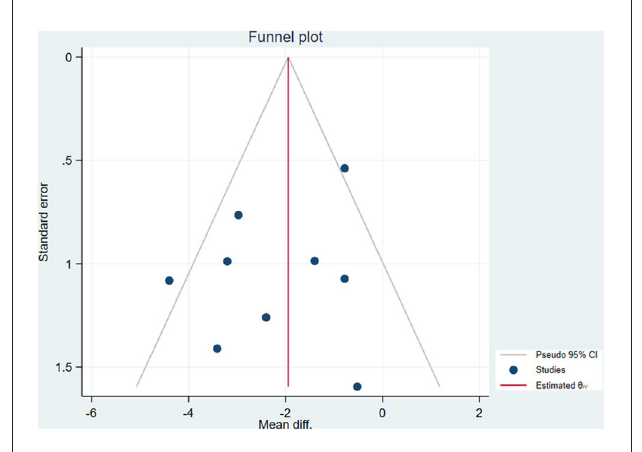
FIGURE2 Funnel plot of the